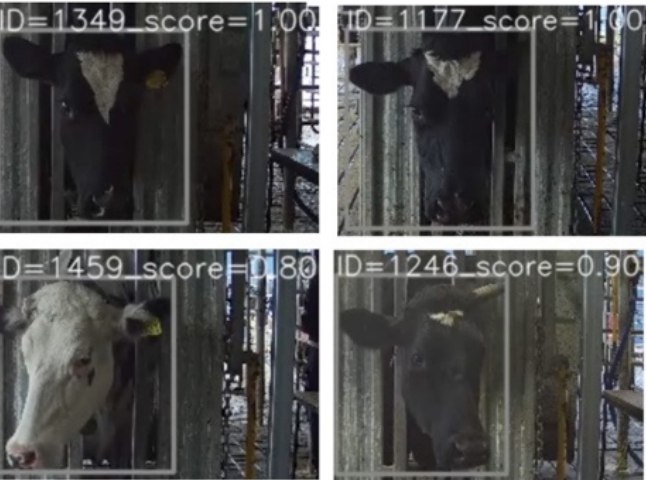
Figure 11. Example of visualized identified cows with bufID and bufScore processed on video sequence with buffer size of 10.